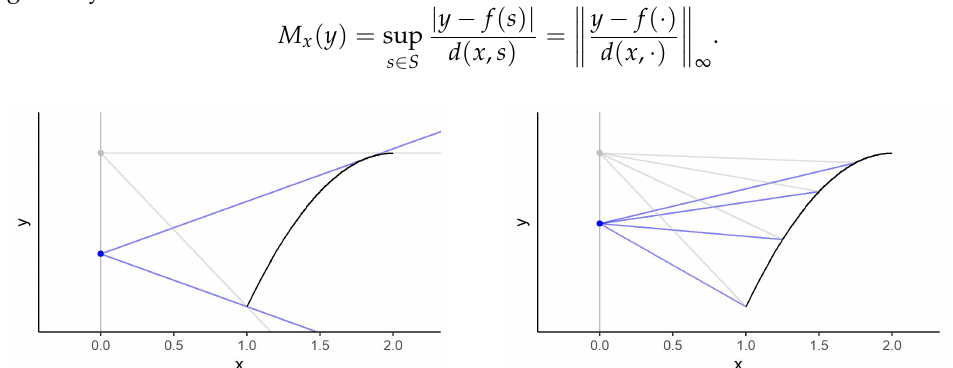
Figure 1. Geometric construction by Oberman and Milman ( left ) and the one that minimizes M p x ( y ) for p = 2 ( right ). In black, the graph of f ( x ) = − x 2 + 4 x − 3 for 1 ≤ x ≤ 2, to be extended to the point x = 0. In blue, the point y that minimizes the problem, and in grey, an example point, y =